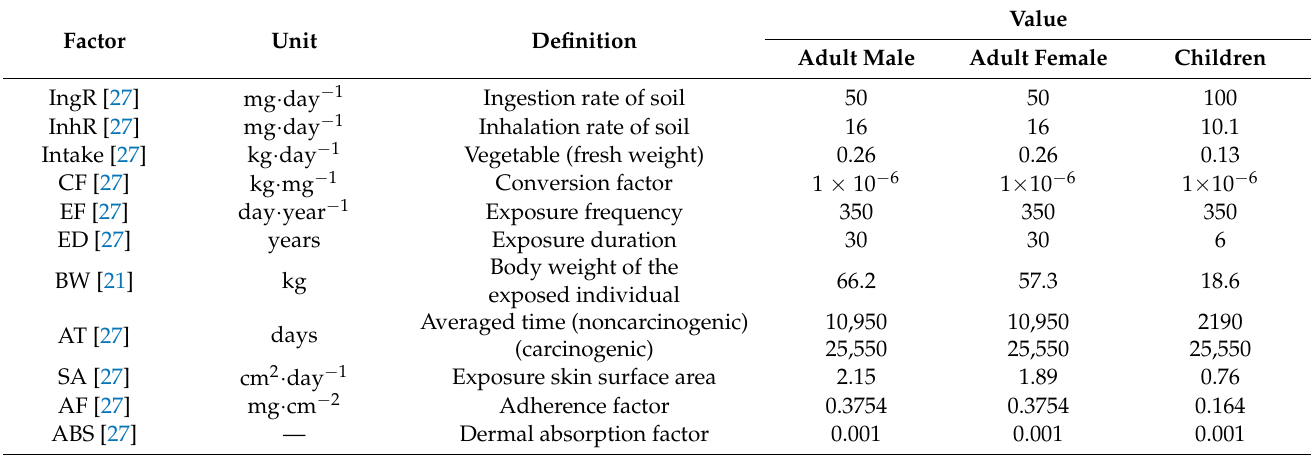
Table 1. Reference parameter values adopted in the health risk